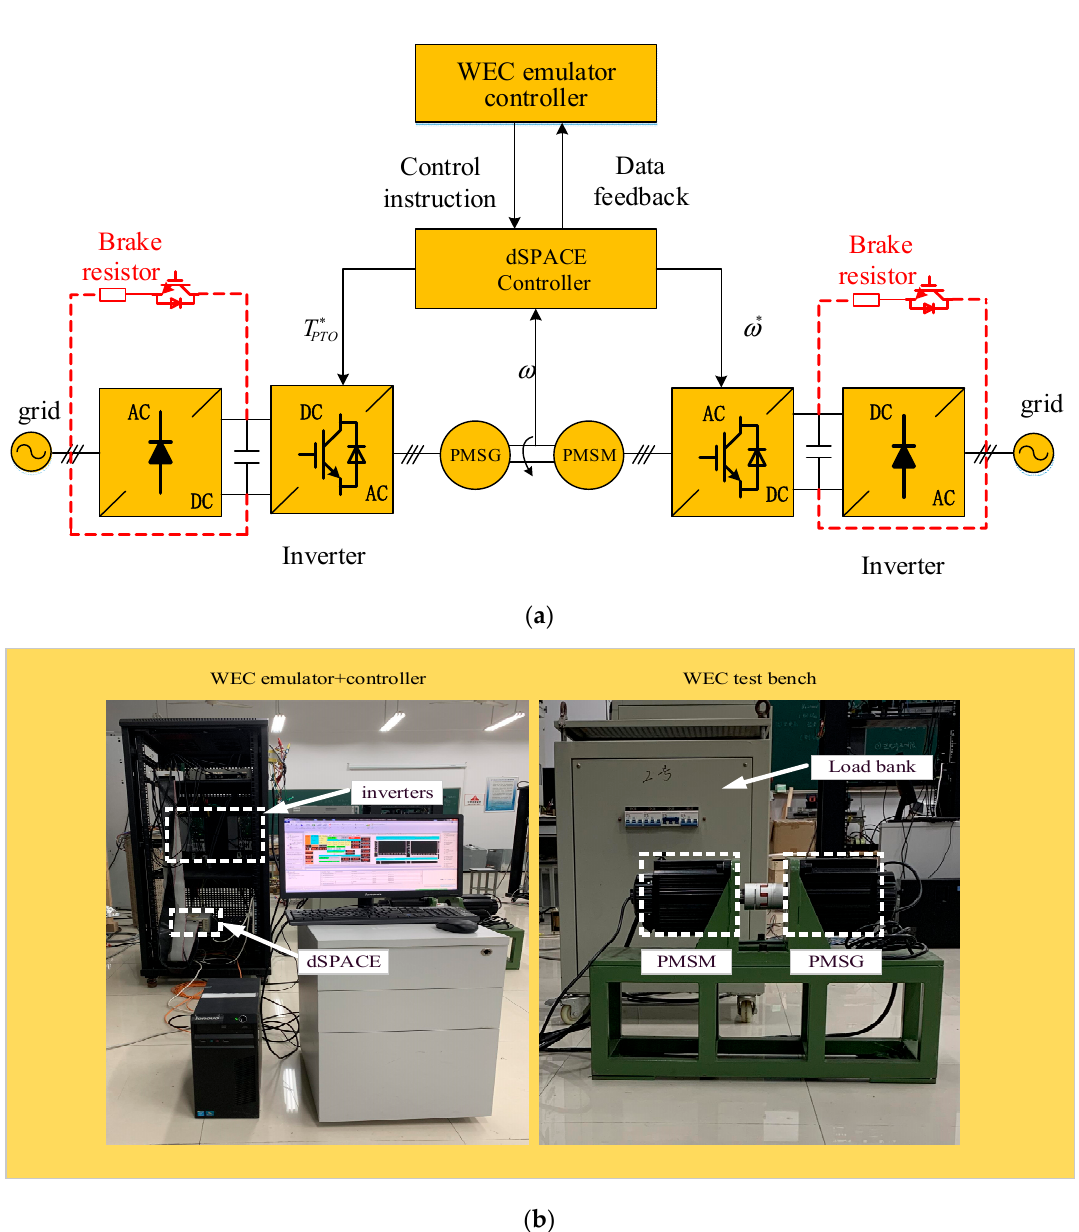
Figure 13. Synchronous test bench, ( a ) overall control block diagram in the laboratory and ( b ) experimental setup.